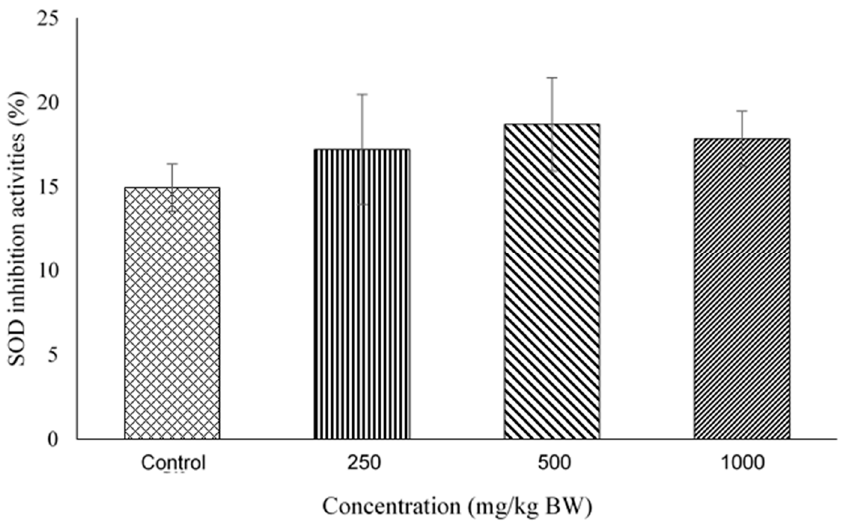
Figure 4. SOD inhibition activities in maternal rat’s placenta. The bar chart shows the percentage of SOD inhibition activities in the maternal rat’s placenta of control, 250, 500 and 1000 mg/kg BW. Data values were expressed with mean ± SEM ( n = 5). No significant difference between all groups ( p > 0.05).